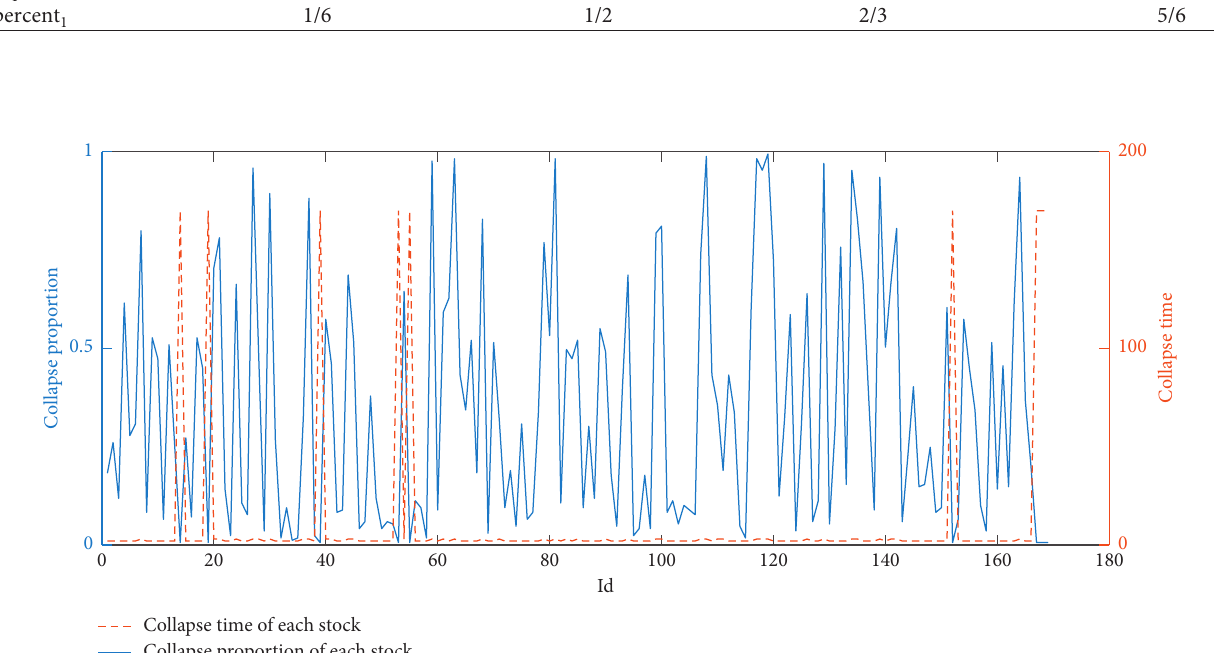
Figure 11: Collapse proportion and time originated from each